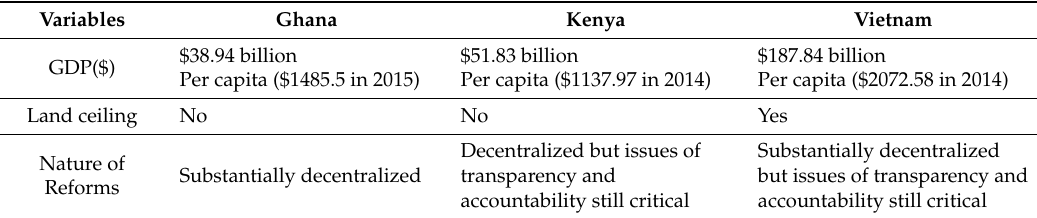
Table A1. Summary of key variables, comparing case study countries.